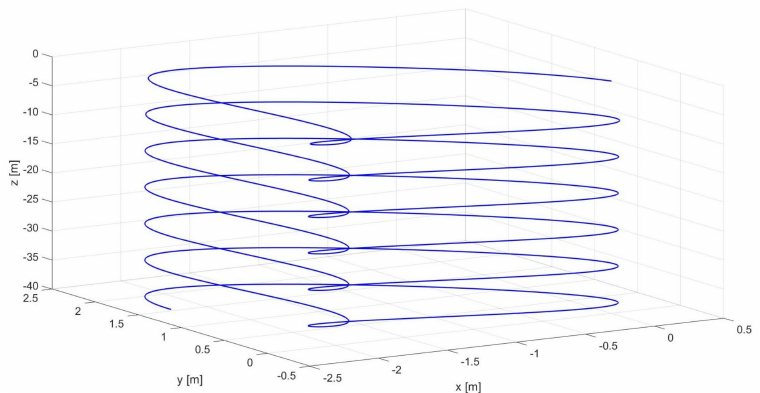
Figure 14. 3D view of trajectory 2: position trajectory of the controlled quadrotor